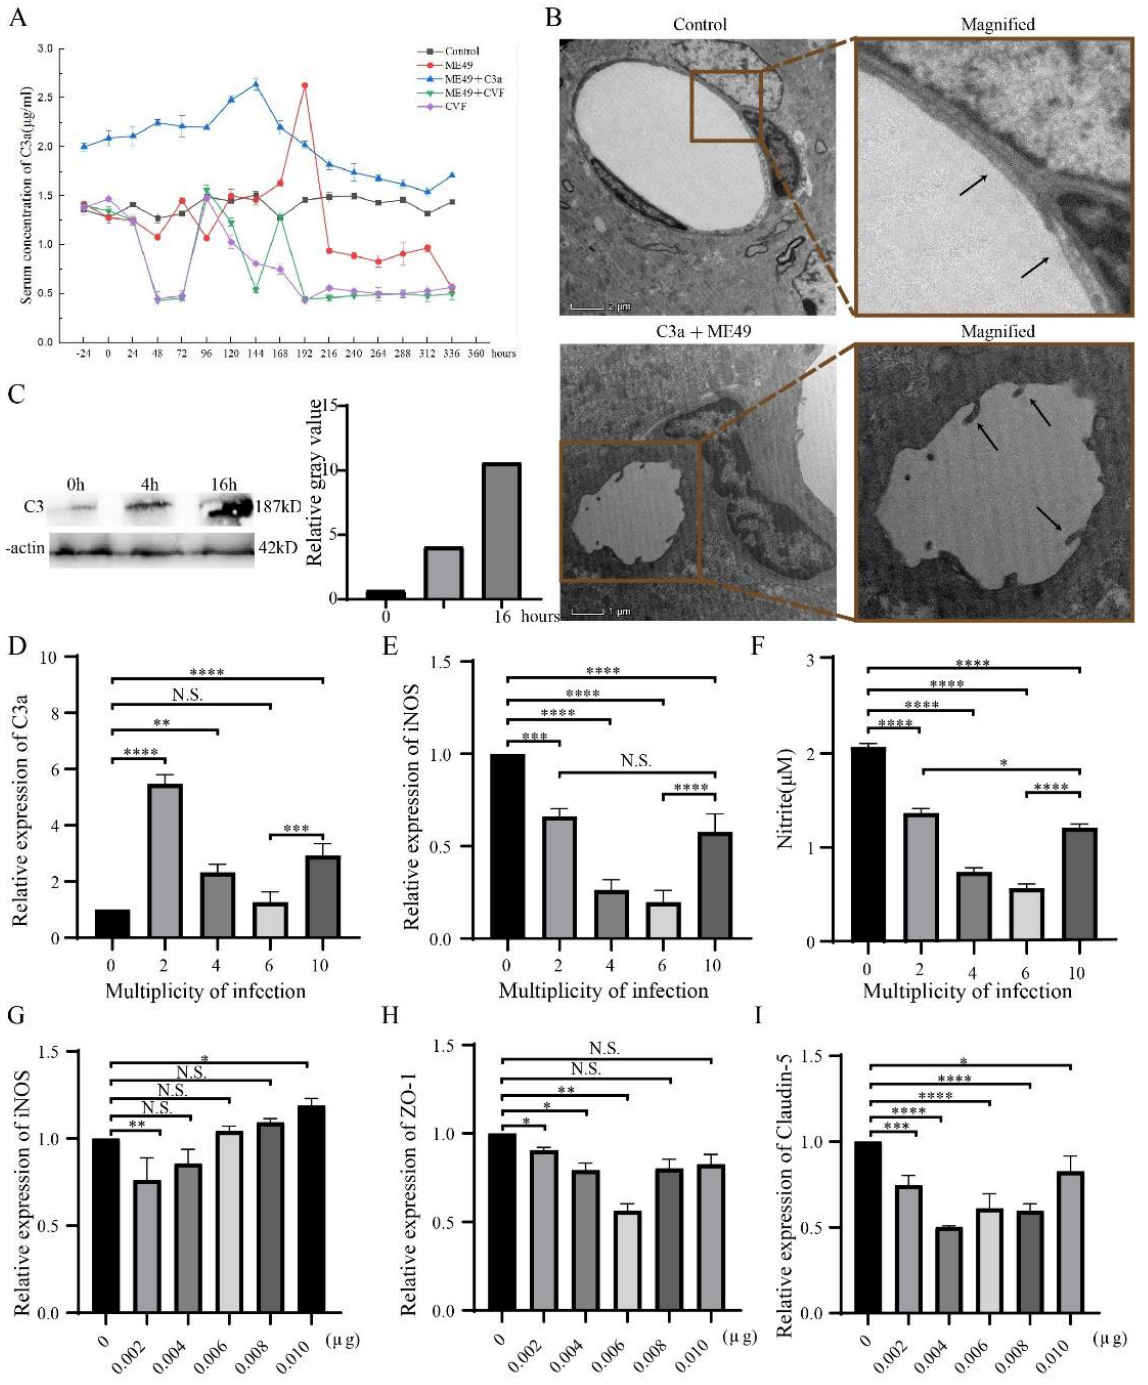
Figure 1. T. gondii promoted the expression of C3a and induced the disruption of BBB as observed by TEM analysis of BMEC. ( A ) Change trends of C3a in the blood of mice treated with ME49, C3a and CVF from – 24 to 336 h. ( B ) TEM photos of the control group and C3a + ME49 at 144h. Magnification: control, denomination: 6700 × ; C3a + ME49, denomination:3400x. ( C ) The expression of C3 in bEnd3 cells with increasing T. gondii infection time. ( D – F ) Expression changes of C3a, iNOS and Nitrite in bEnd3 cells with different MOI of T. gondii. Using β -Actin to normalized ( D , E ). ( G – I ) Expression changes of iNOS, ZO-1, and Claudin-5 in bEnd3 cells with different concentrations of C3a. β -Actin is used to normalize. Statistical differences were analyzed by one-way ANOVA. N.S. p ≥ 0.05, * p < 0.05, ** p < 0.01, *** p < 0.001, **** p < 0.0001. 2.2. SB290157 Combined with C3a at Low Concentration Inhibited the Expression of C3a, iNOS, and Vimentin SB290157 is a common C3aR antagonist which can inhibit C3a by competitive bind- ing with C3aR [27]. Vimentin is the main component of the cytoskeleton and significantly rearranges around PV during T. gondii infection [39]. To further observe the relation be- tween C3a and BBB permeability, statistical analysis was done by comparing the ME49, different concentrations of C3a and SB290157 groups with the control group. Interestingly, ME49, C3a (0.01 μg and 0.05 μg), and SB290157 can promote the expression of C3a and iNOS in bEnd3 cells compared with the control group. BEnd3 cells treated with a low